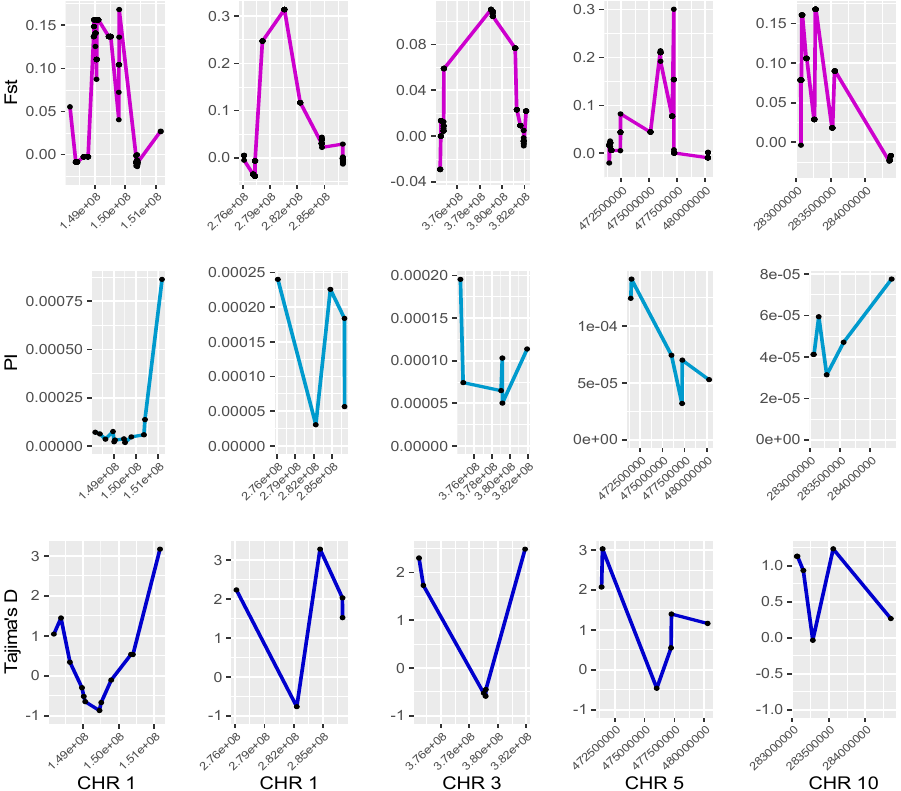
Figure 3. Selective sweeps in the giant sequoia genome. Patterns of nucleotide diversity (PI) and differentiation (Fst and Tajima’s D) were evaluated using sliding windows to locate genomic regions showing signatures of positive selection. Five of the longest outlier genomic regions in chromosomes 1, 3, 5, and 10 are shown.